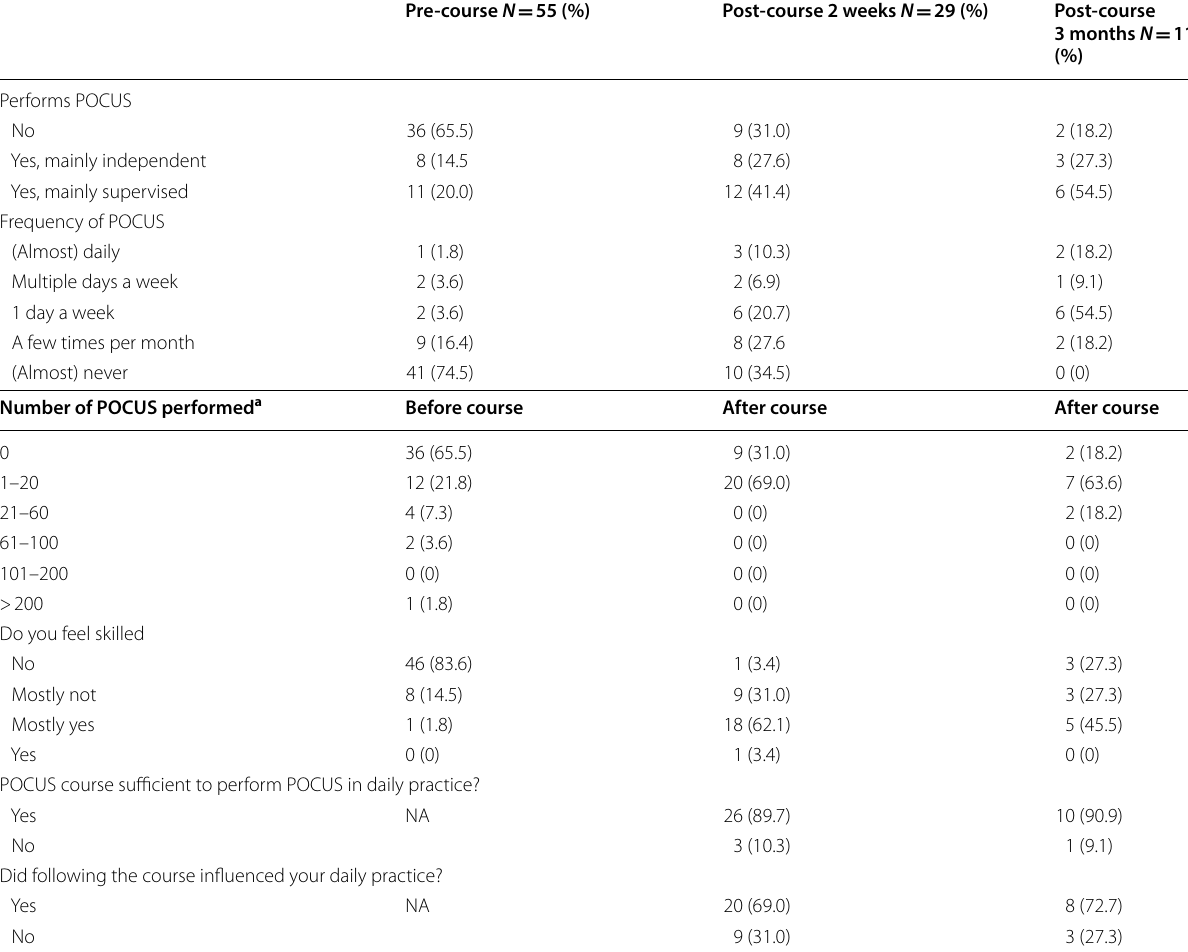
Table 2 Effect of ultrasound course on performing POCUS